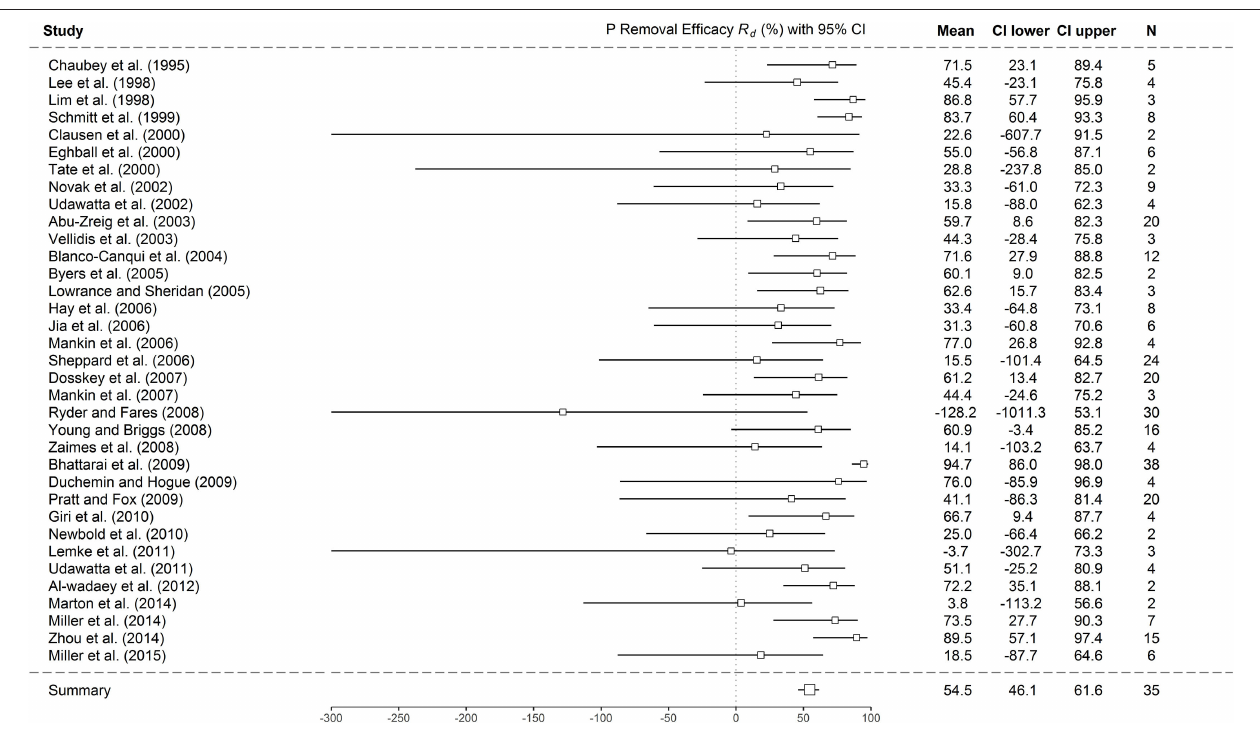
FIGURE 3 | Plot showing the mean and 95% confidence interval of P removal efficacy ( R d ) for each of the 35 studies. The P removal efficacy pooled from these 35 studies is shown in the “Summary” row. N represents the number of RB observations of a study or, for the case of “Summary,” the number of studies pooled.